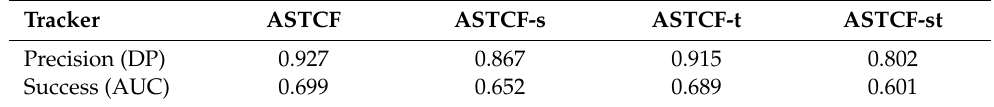
Table 6. DP scores and AUC scores of different versions of ASTCF on OTB2015